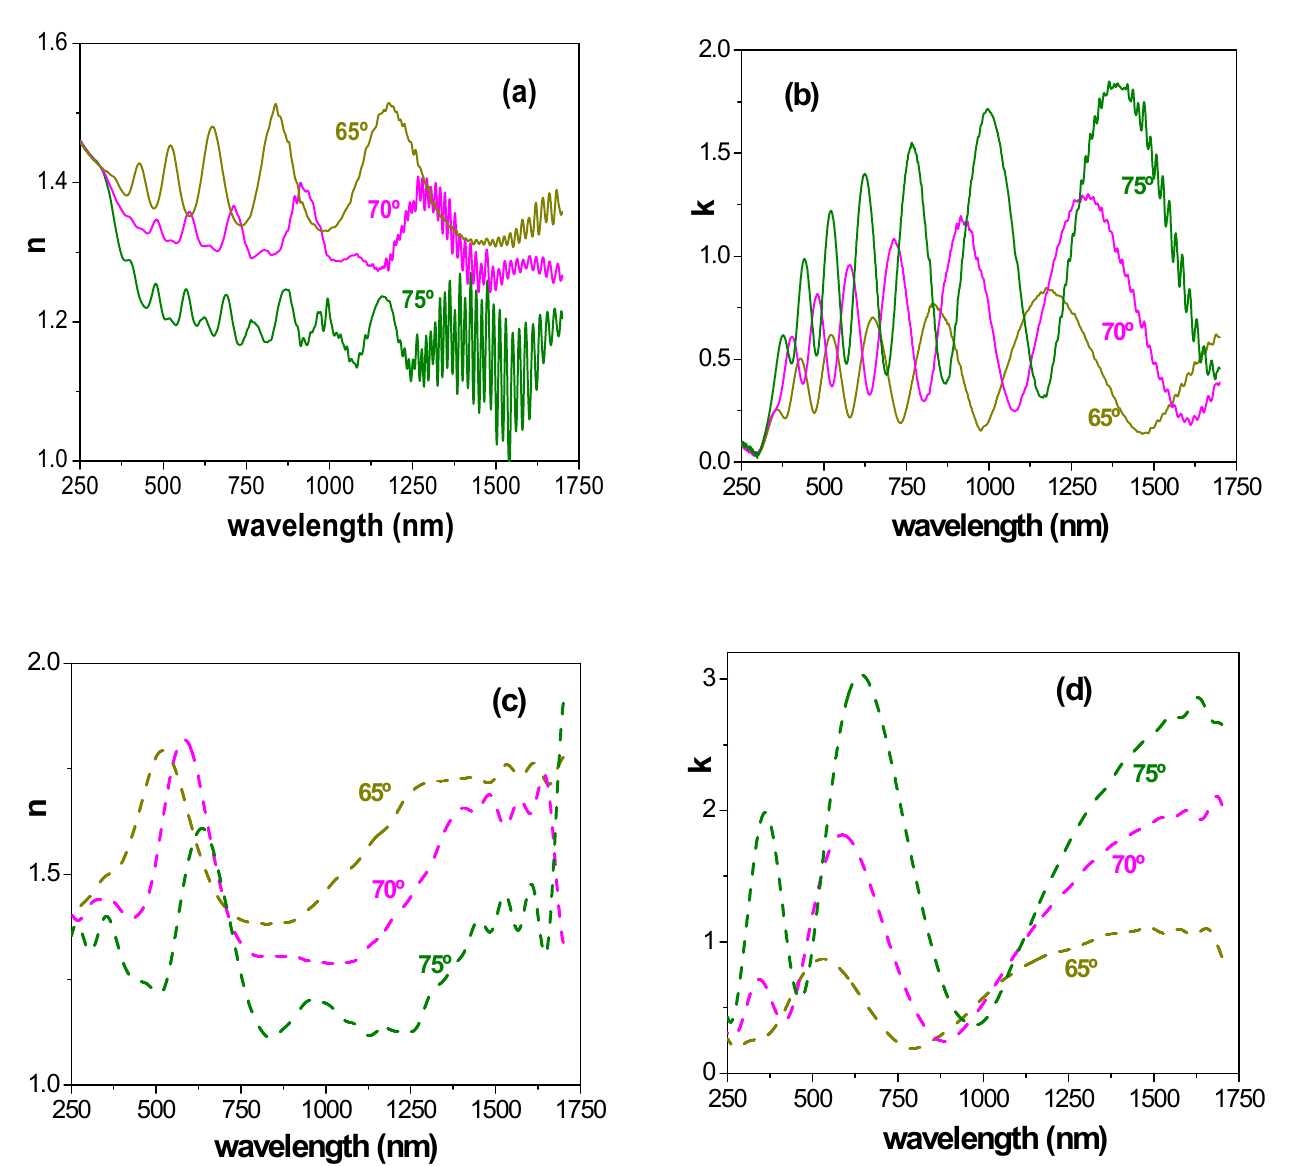
Figure 4. Wavelength dependence for the refraction index (n) and the extinction coefficient (k) at the three light incident angles: 65 ◦ (dark yellow lines), 70 ◦ (magenta lines), and 75 ◦ (green lines). ( a , c ): refraction index; ( b , d ): extinction coefficient. Solid lines: Ox(A)/SiO 2 sample; dashed lines: Ox(B)/SiO 2 sample.